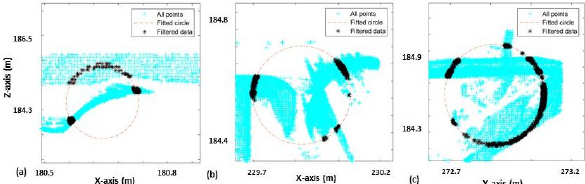
Figure 19. Sample identified locations where rollers were not present.